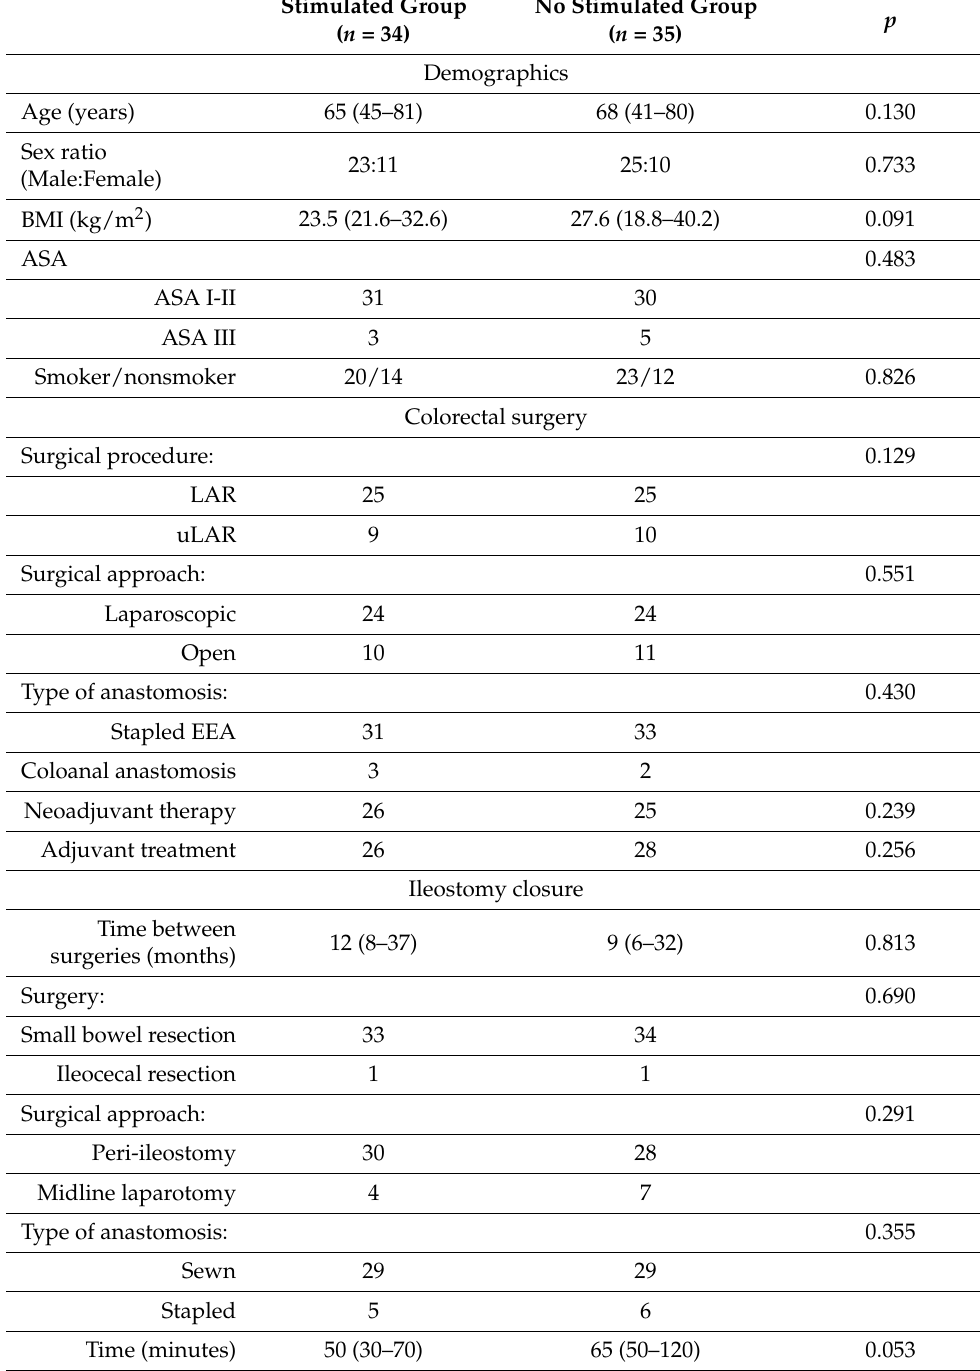
Table 1. Demographics, clinics and surgical